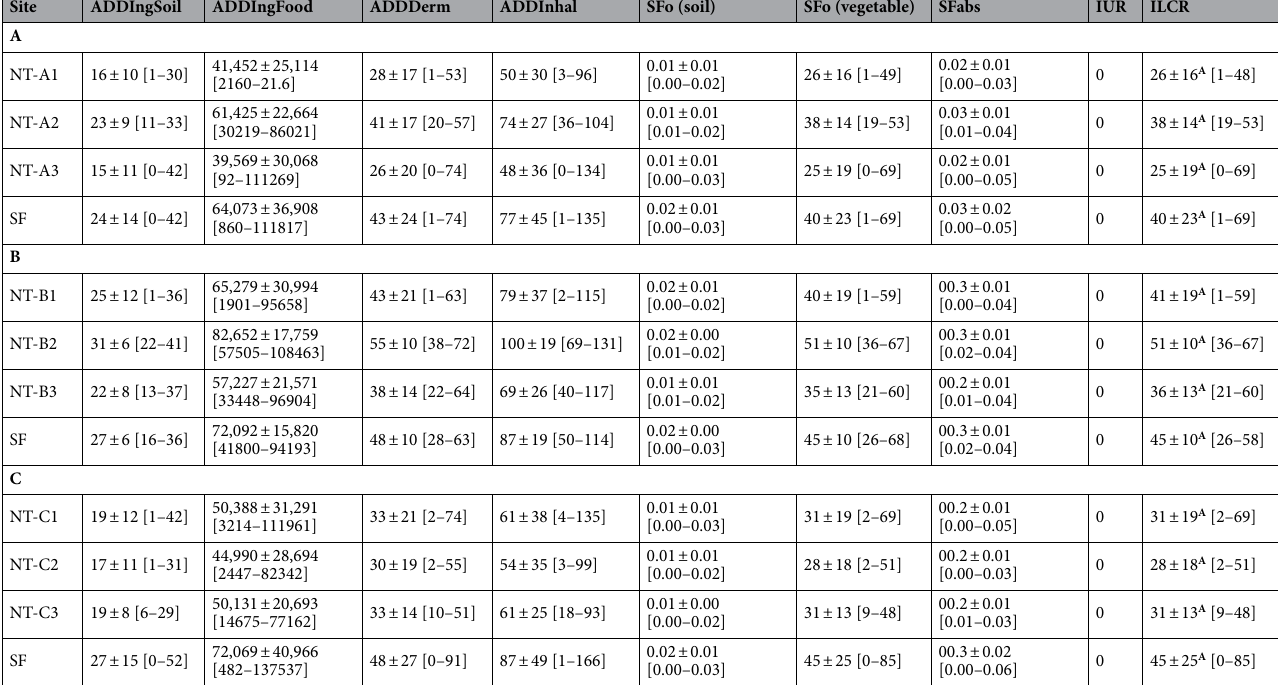
Table 3. Incremental lifetime cancer risk (ILCR) from average daily dose (ADD, mg/kg/day) by four exposure routes. Soil intake (ADDIngSoil), food intake (ADDIngFood), dermal contact (ADDDerm) and inhalation (ADDInhal). SF values represent the oral slope factor (SFo) and dermal contact (SFabs). IUR represents the inhalation unit risk (unitless). Data presents the average ± standard deviation and [minimum–maximum] values. Different letters represent a significant